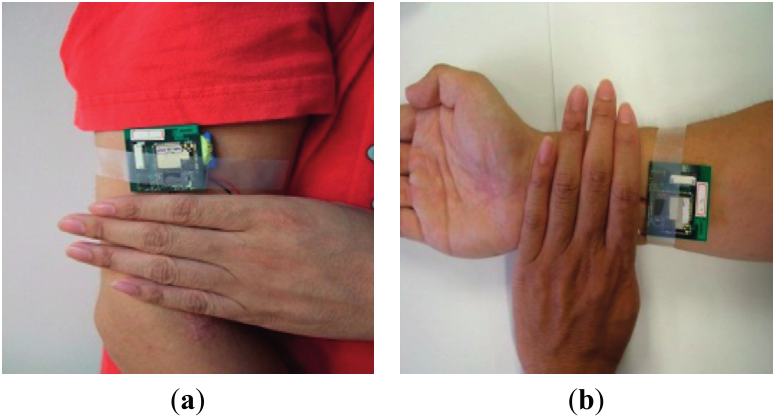
Figure 3. Portions of the arm for wearing inertial sensor node: ( a ) Node 1 at upper arm; ( b ) Node 2 at